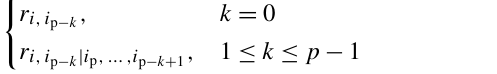
is worth noting that the parent set S i for node i does not have a unique